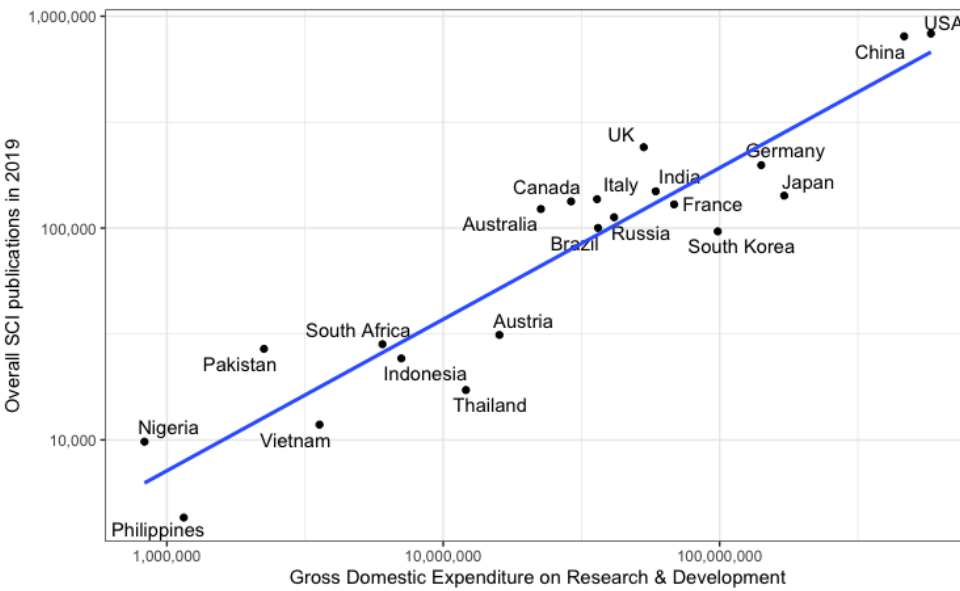
Figure 21. Papers published in 2019 in relation to the gross domestic expenditure on research and development in 2019 for selected countries (sources: United Nations Statistics Division and the Web of